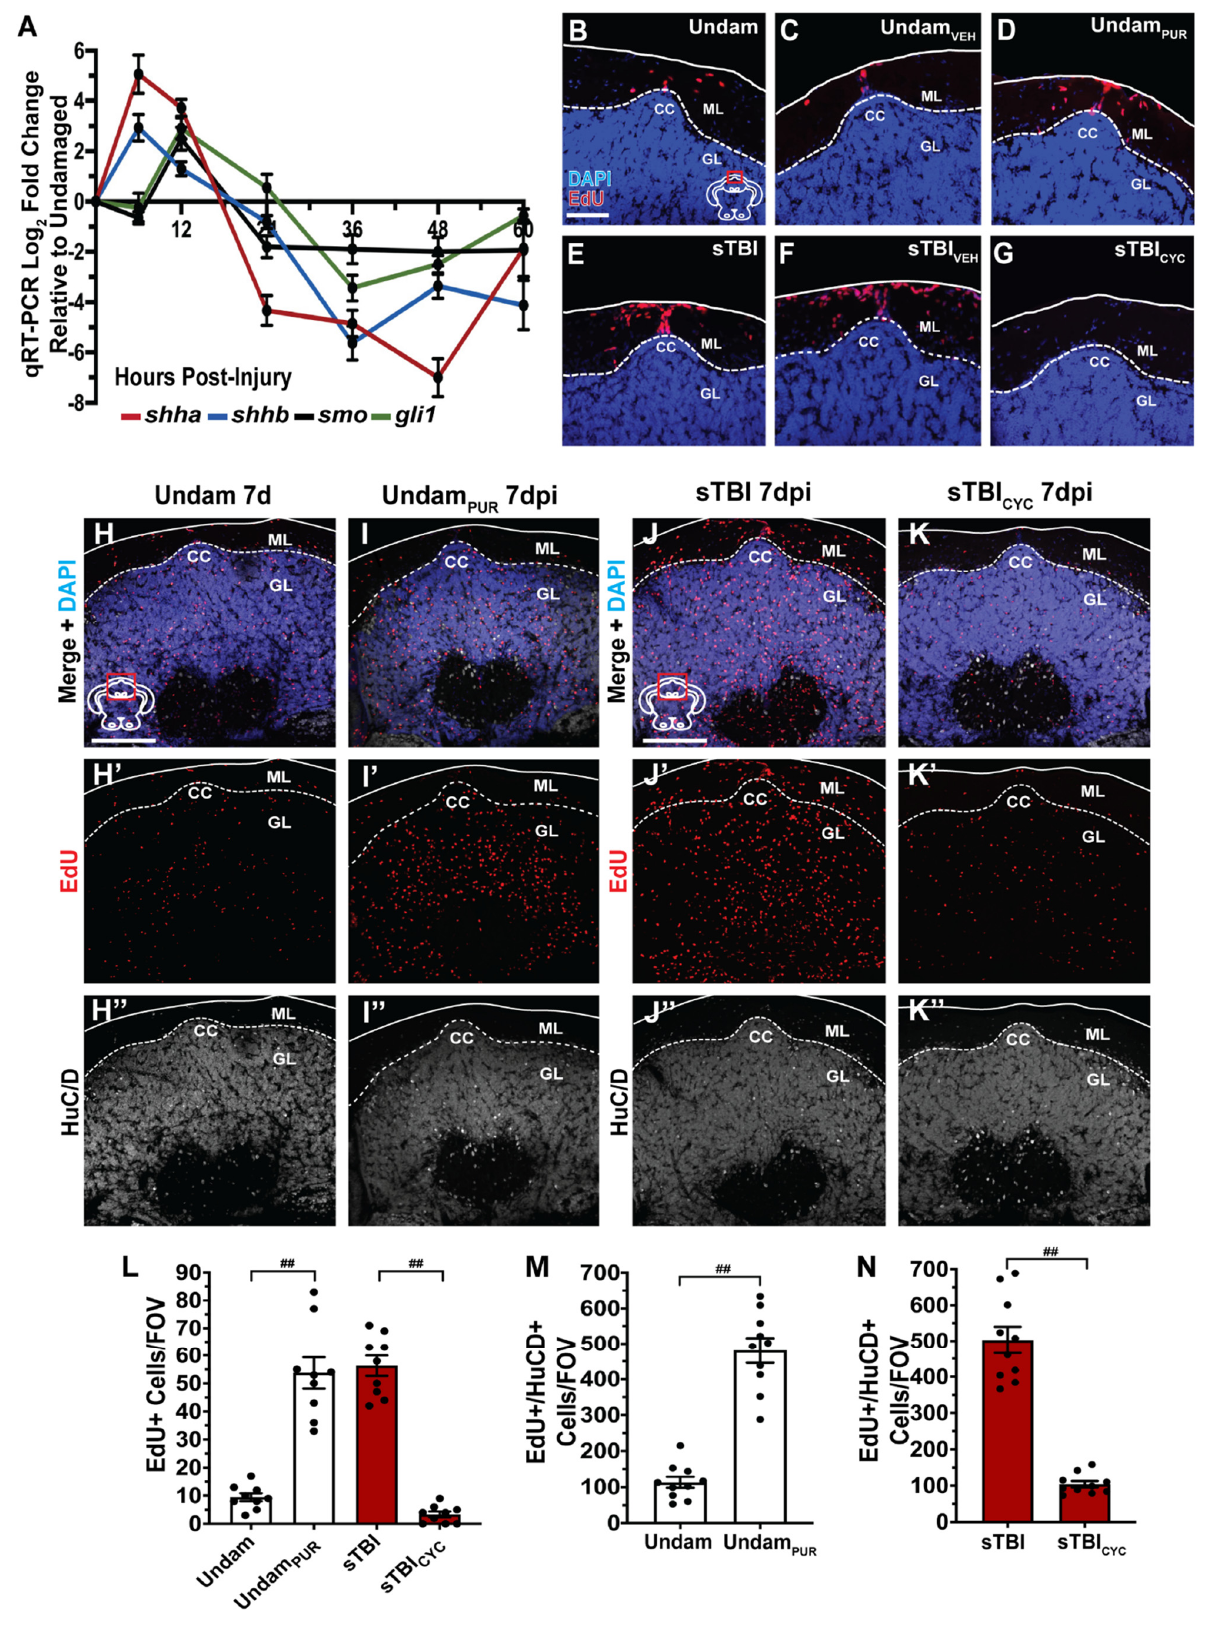
Figure 11. Shh regulates cerebellar proliferation and differentiation following injury. ( A ) Expression of Shh pathway genes by qRT-PCR reveals that the shha and shhb mRNAs are upregulated by 4 hpi in the top 1/3 rd of the cerebellum, while gli